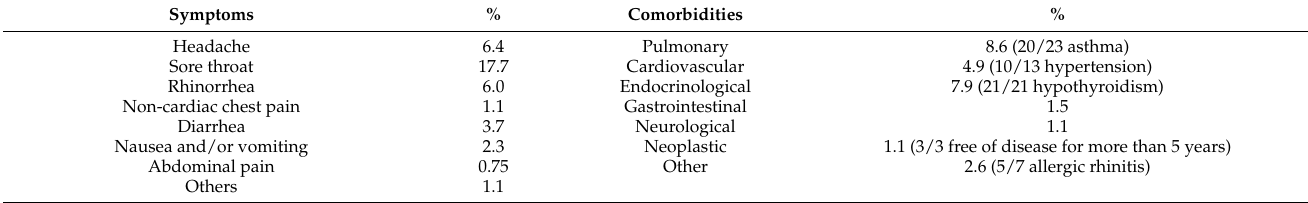
Table 1. Prevalence of symptoms and comorbidities amongst enrolled subjects.